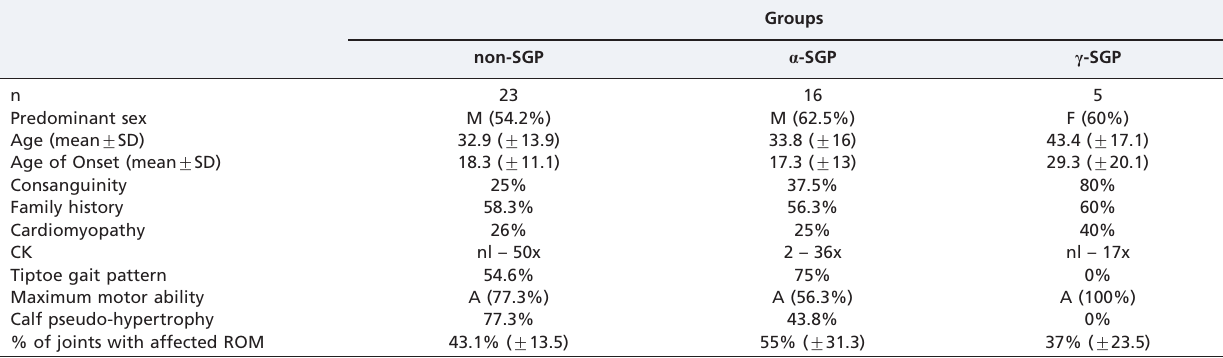
Table 1 - Demographic and clinical data collected from the patients.